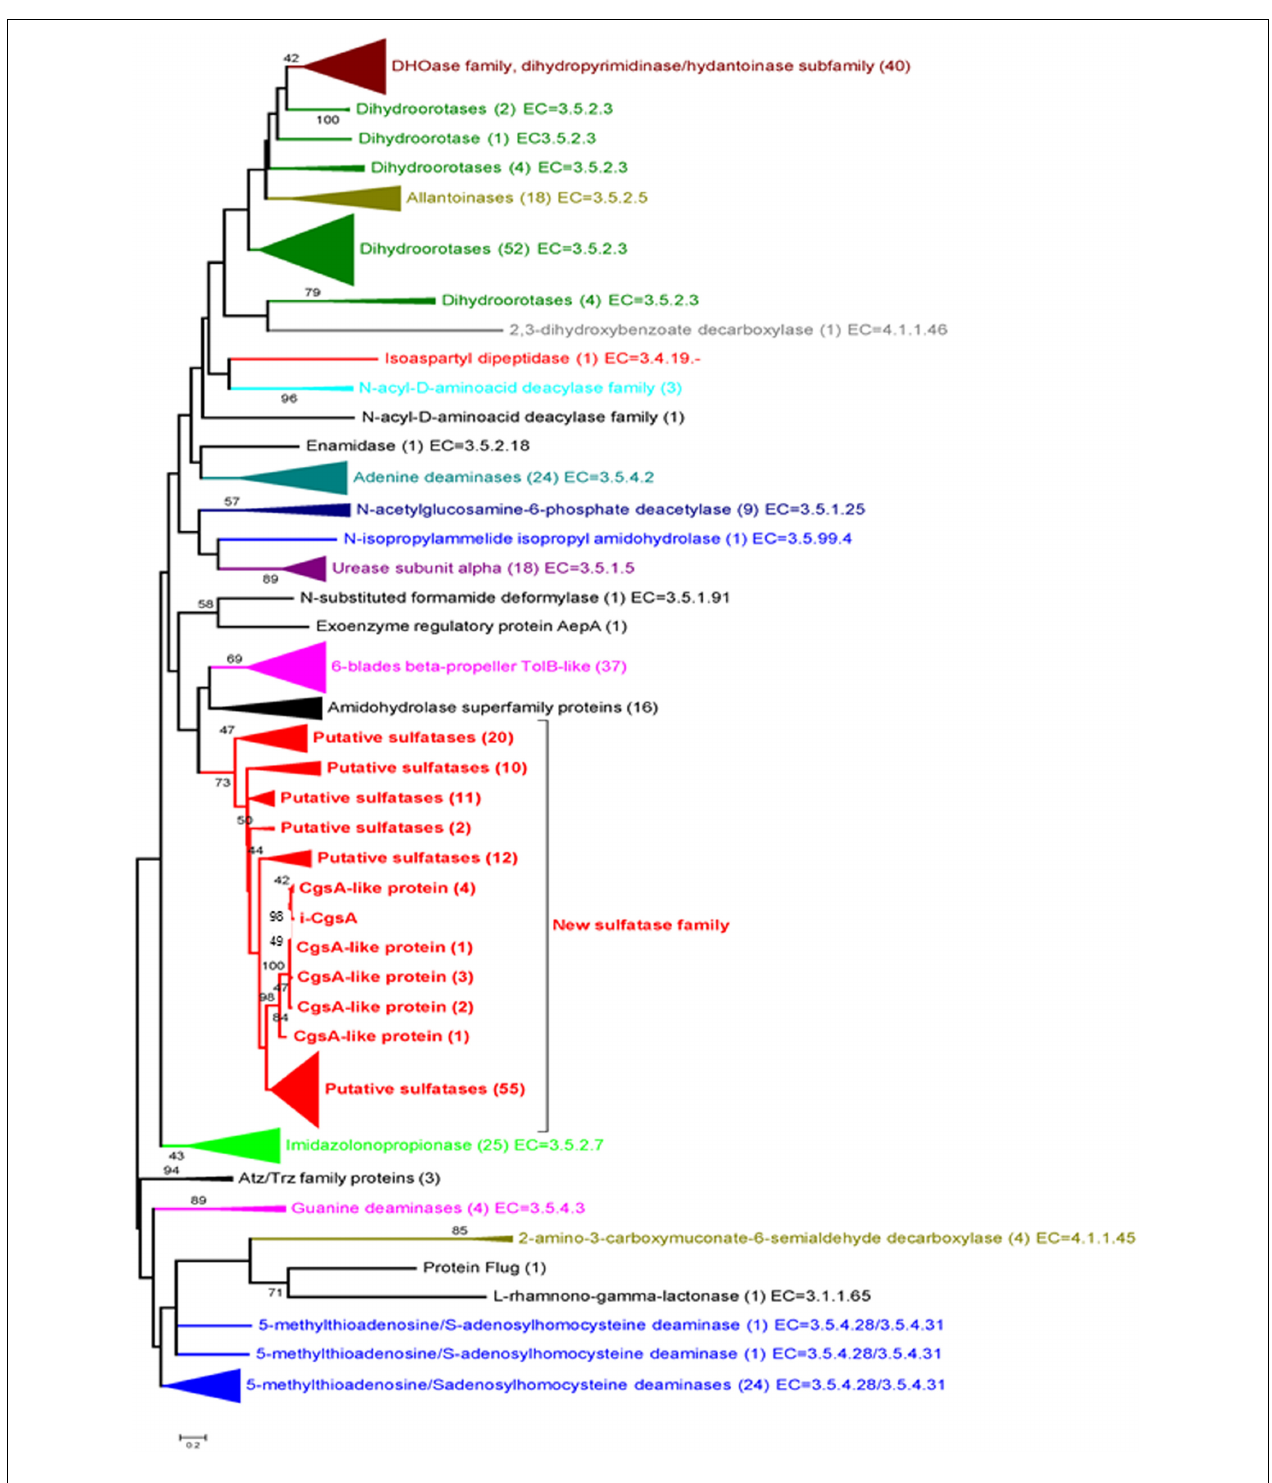
FIGURE 6 | Phylogenetic tree of the amidohydrolase module present in Psc ι -CgsA and in 420 sequences of enzymes classified as amidohydrolases. The maximum likelihood tree was built with the MEGA v. 5.05. Software, using the substitution model WAG. Evolutionary rate differences among sites (5 categories) were modeled using a discrete Gamma distribution, from an alignment produced by the MAFFT program with the L-INSi algorithm (Katoh et al., 2005). Phylogenetic analysis was